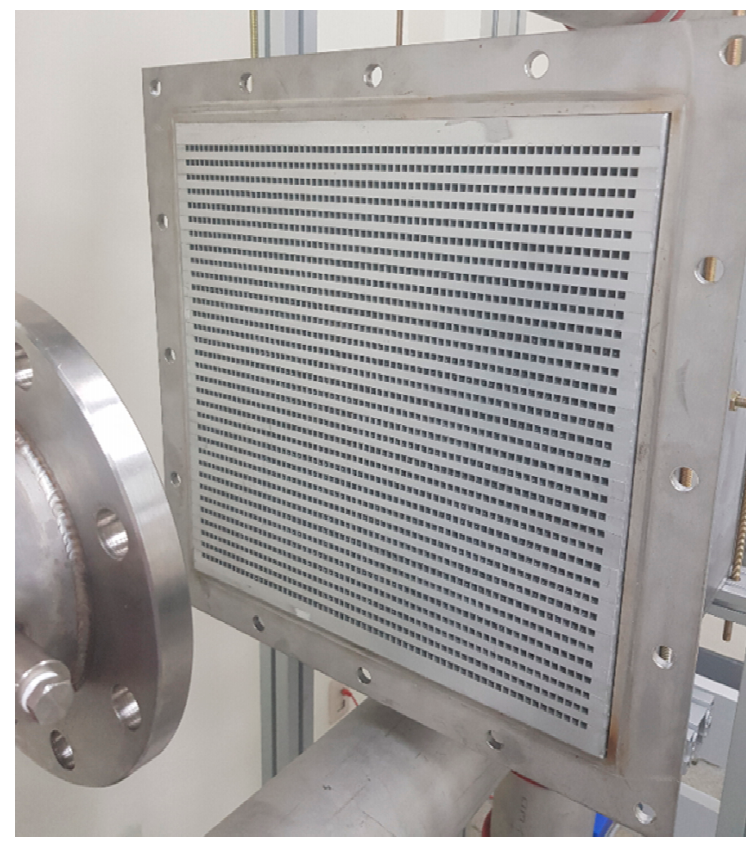
Figure 9. Exit view of the 33 × 66 channels in the heat exchanger unit.